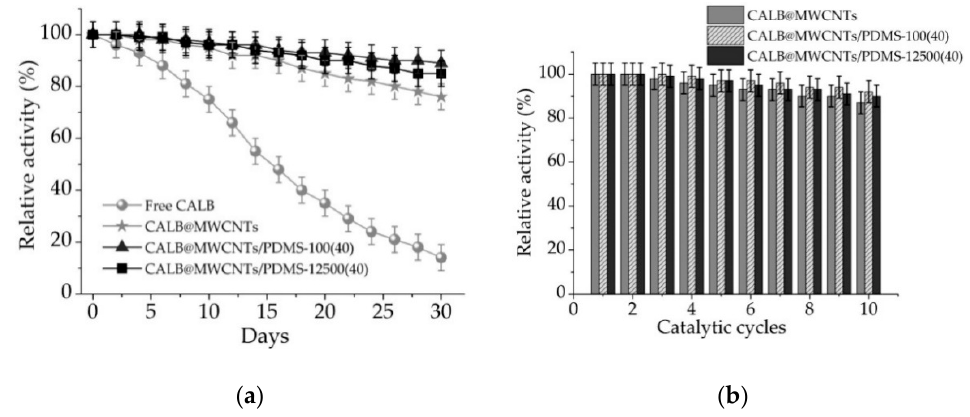
Figure 7. ( a ) Storage stability and ( b ) reusability of free lipase and enzyme immobilized onto P-MWCNTs and MWCNTs/PDMS nanocomposites.